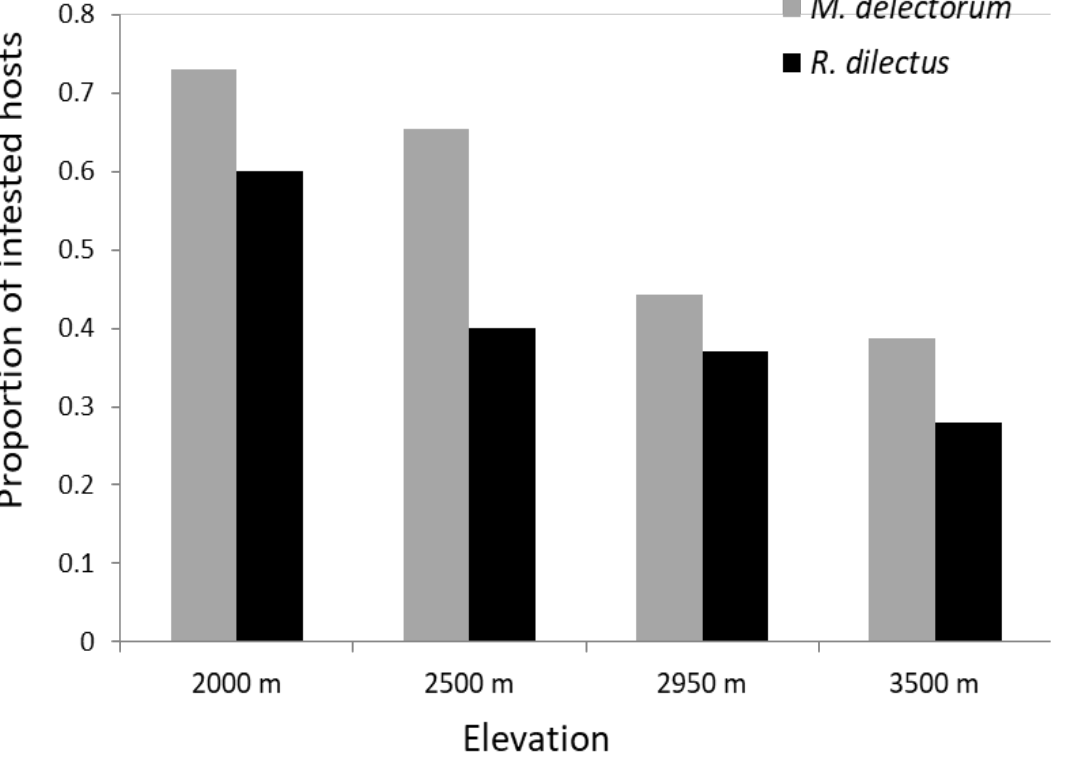
Figure 6. Ectoparasite prevalence of M. delectorum and R. dilectus in relation to elevation on Mount Meru.